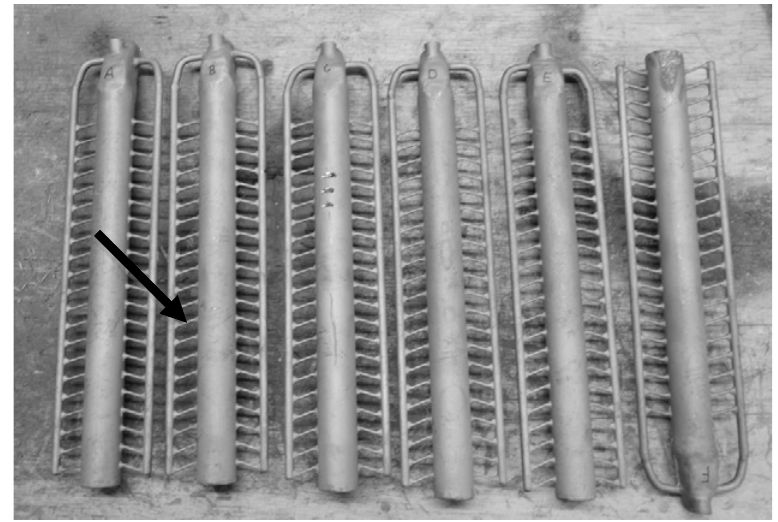
Figure 3. Cast cylindrical implants ( → ) before separation from the feed channel.